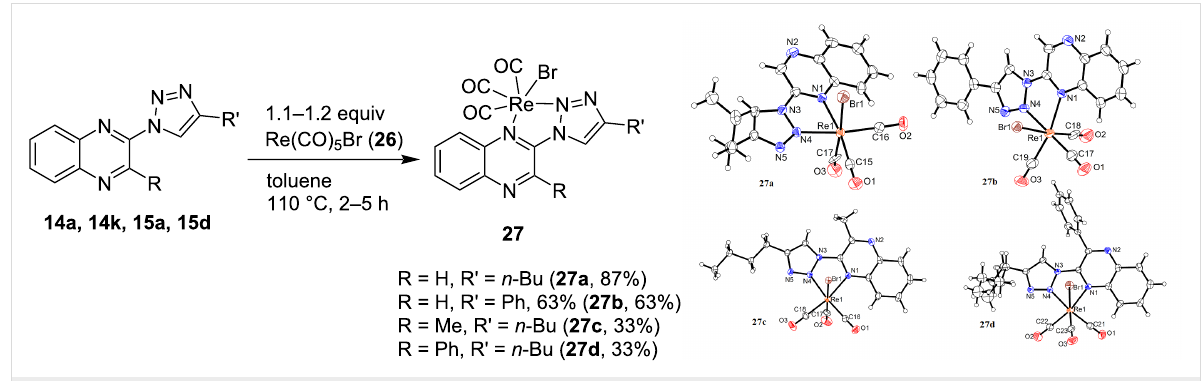
Scheme 6: Synthesis of rhenium tricarbonyl complexes 27a–d and ORTEP diagrams of the resulting molecular structures with the thermal ellipsoids shown at 50%